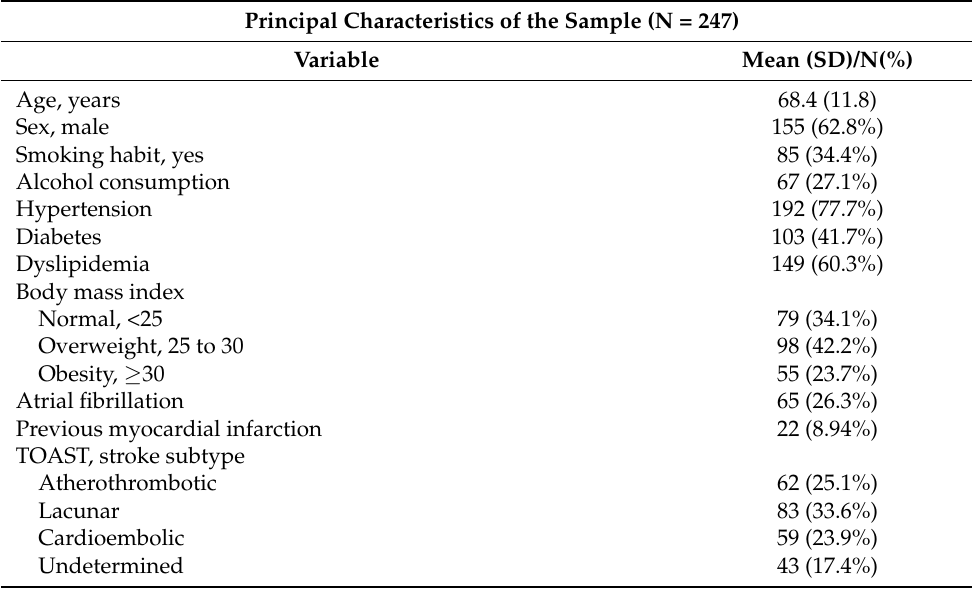
Table 1. Data are presented as frequencies and percentages or mean and standard deviations. Principal Characteristics of the Sample (N =